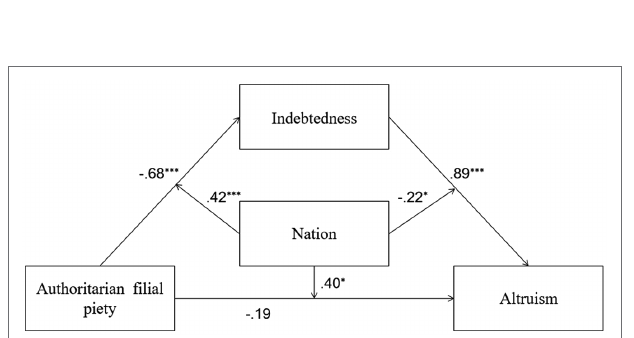
FIGURE 7 | Moderated mediation model showing standardized coefficients (Model 7); * p < 0.05; *** p < 0.001.